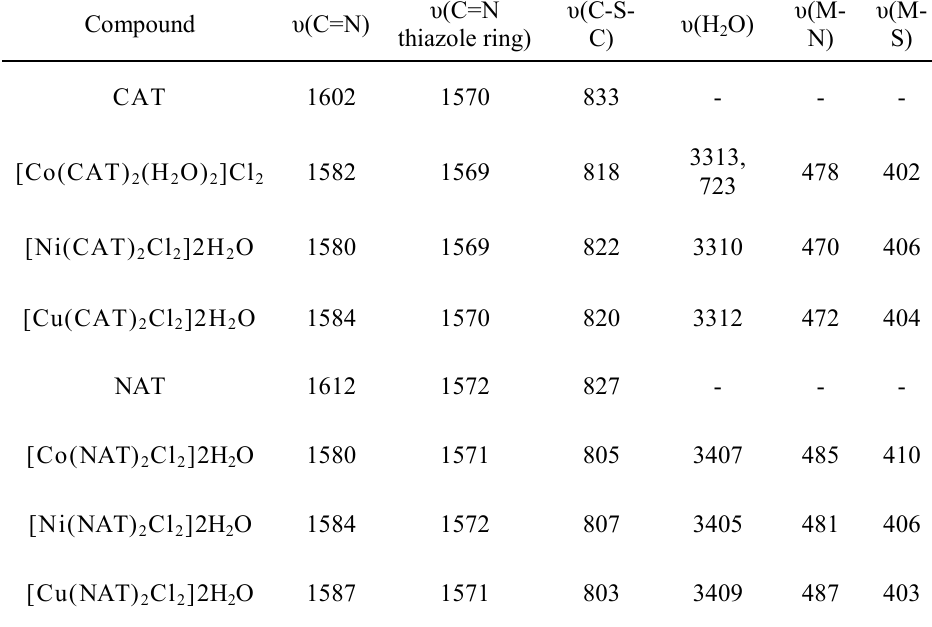
Table 2. IR bands of Schiff base ligands and their